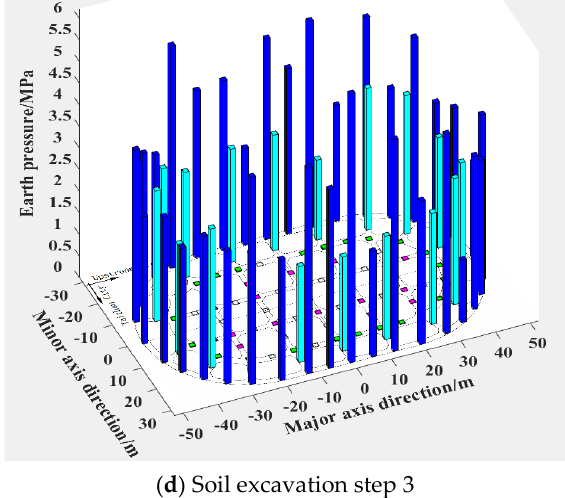
Figure 12. Distribution of earth pressure with soil excavation step by numerical analysis (the blue for the outer bulkhead area, turquoise for the outer partition area, green for the inner bulkhead area, and magenta for the inner partition wall area).